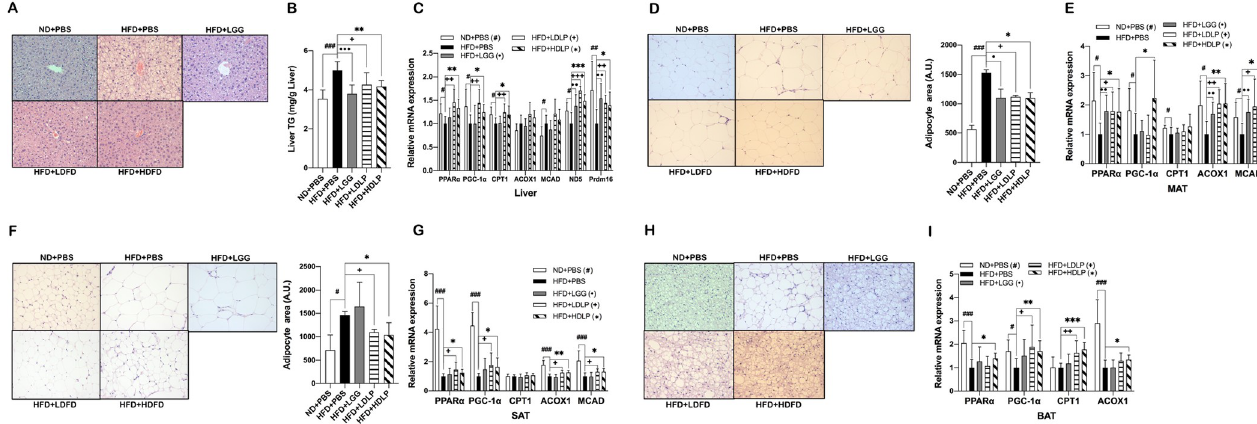
Fig 4. L . plantarum treatment improves lipid oxidation in the liver and white adipose tissue. (A) Changes in hepatic adiposity after 12 weeks of L . plantarum treatment. Shown are representative photomicrographs (200X) of the liver sections stained with hematoxylin and eosin (n = 3). (B) Effect of L . plantarum treatment on the liver TG accumulation (n = 8). (C, E, G, and I) Effect of L . plantarum treatment on mRNA expression related to fatty acid oxidation in the liver, MAT, SAT, and BAT, respectively. (D, F, and H) Changes in adipocyte size in MAT, SAT, and BAT, respectively with representative photomicrographs (n = 3). All genes are normalized to expression of β -actin. mRNA data present mean ± SD for 7~8 mice in each group. Student’s two-tailed t-test was used for analysis of differences between groups. #, •, +, � p < 0.05, ##, ••, ++, �� p < 0.01, ###, •••, +++, ��� p < 0.001.